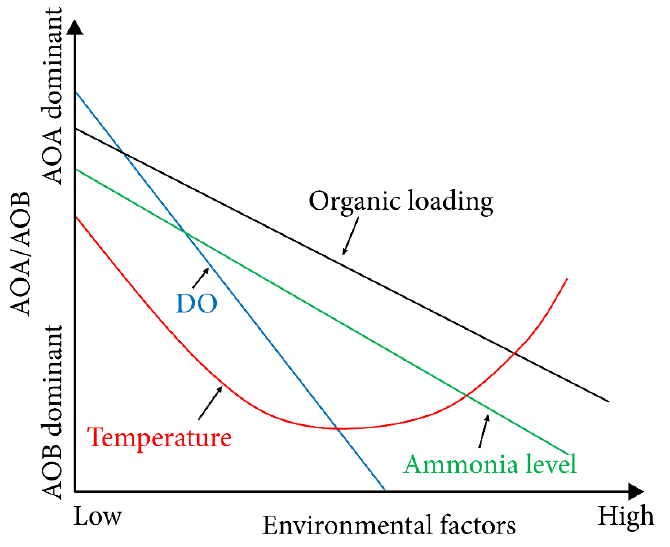
Figure 2. AOA/AOB distribution for varying environmental factors (ammonia, organic loading, oxygen level, and temperature) (based on [11,82]).